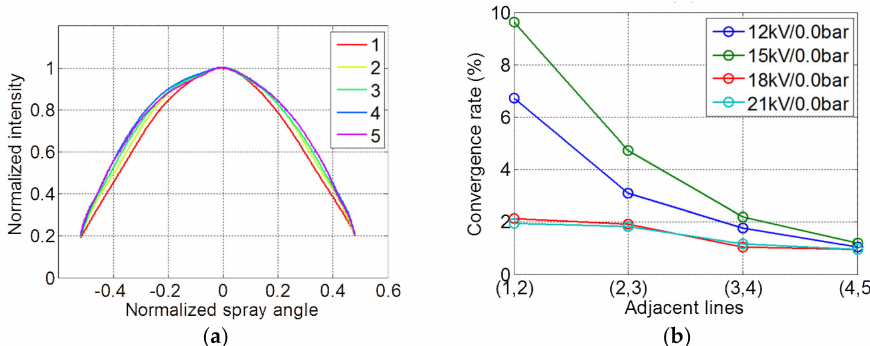
Figure 8. Example of the normalized intensity profiles ( a ) and profile convergence rates calcuated from two adjacent lines ( b ) at the electric field of 15 kV and the pneumatic pressure of 0.0 bar.